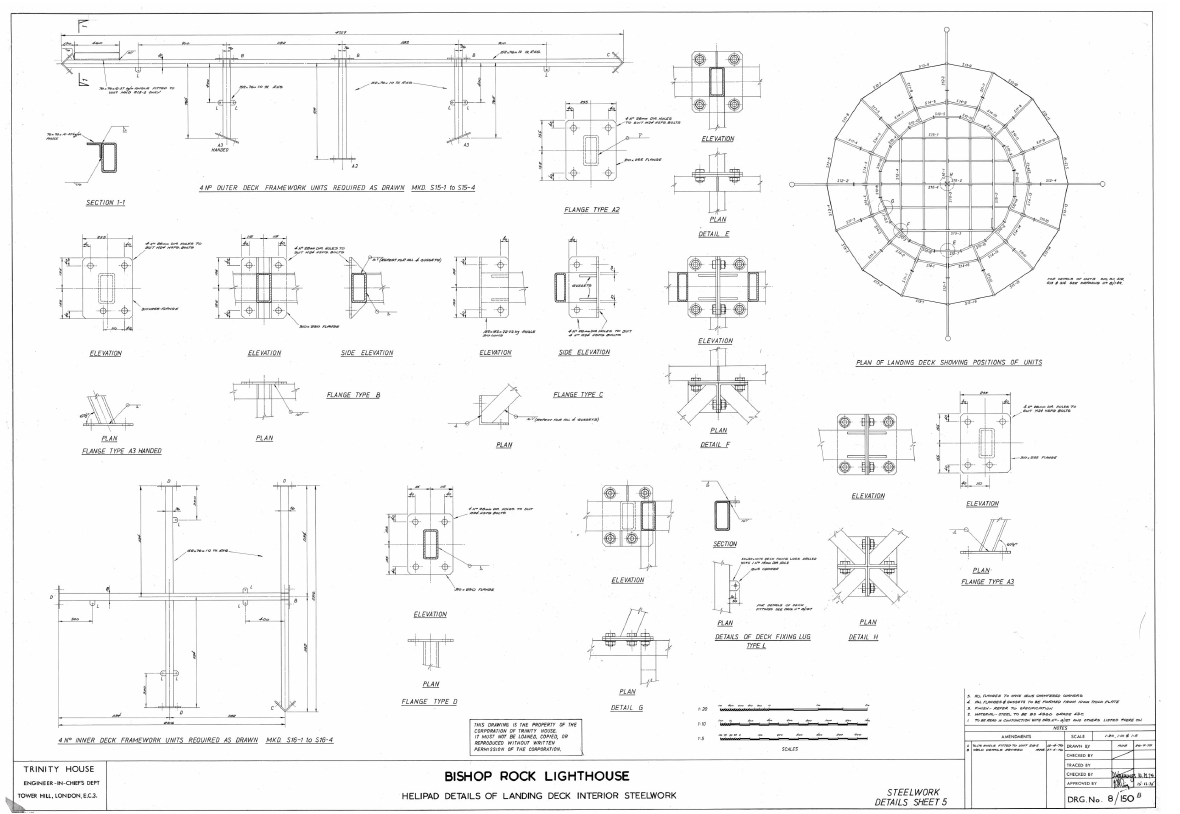
Figure 3. An example of detailed drawings of the current structure [courtesy of Trinity House].